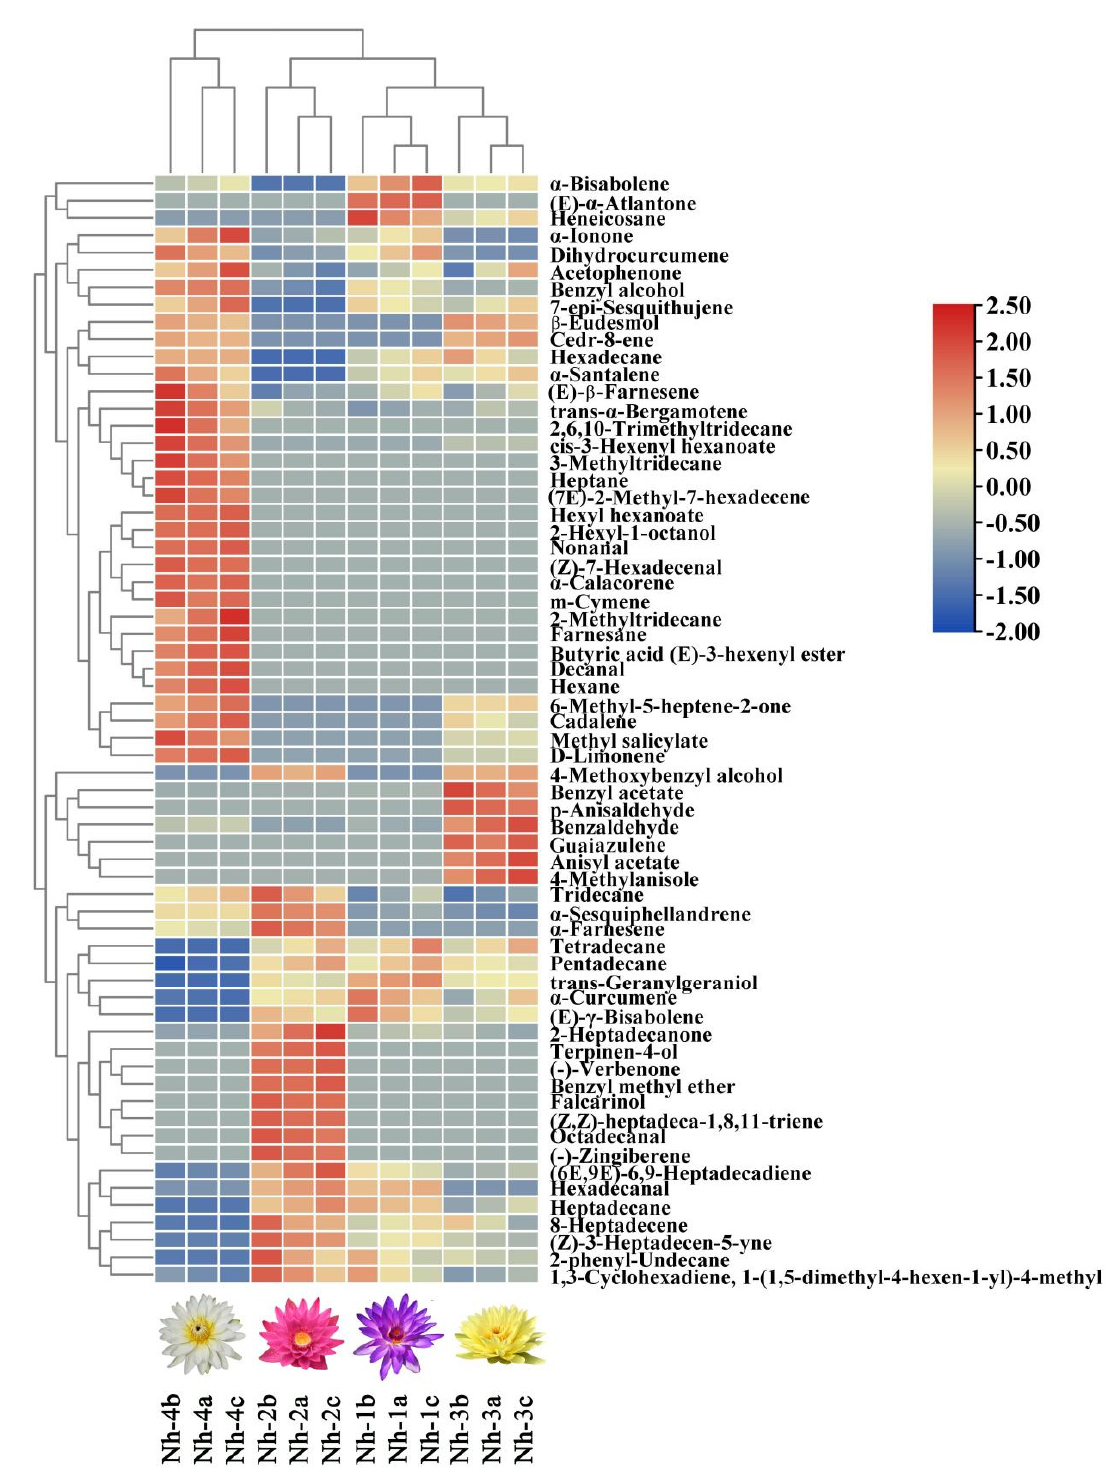
Figure 6. Hierarchical clustering analysis (HCA) and heatmap of volatile compound levels in four strains of N. hybrid . Values of all studied volatile compounds per strain are shown on the heatmap on a blue (negative) to red (positive) scale. The HCA and dendrogram of samples were according to Euclidean distances. Nh − 1a, Nh − 1b, and Nh − 1c indicate the three samples of Nh − 1, and the same is true of Nh − 2, Nh − 3, and Nh − 4; the same labels are used in Figure 7.